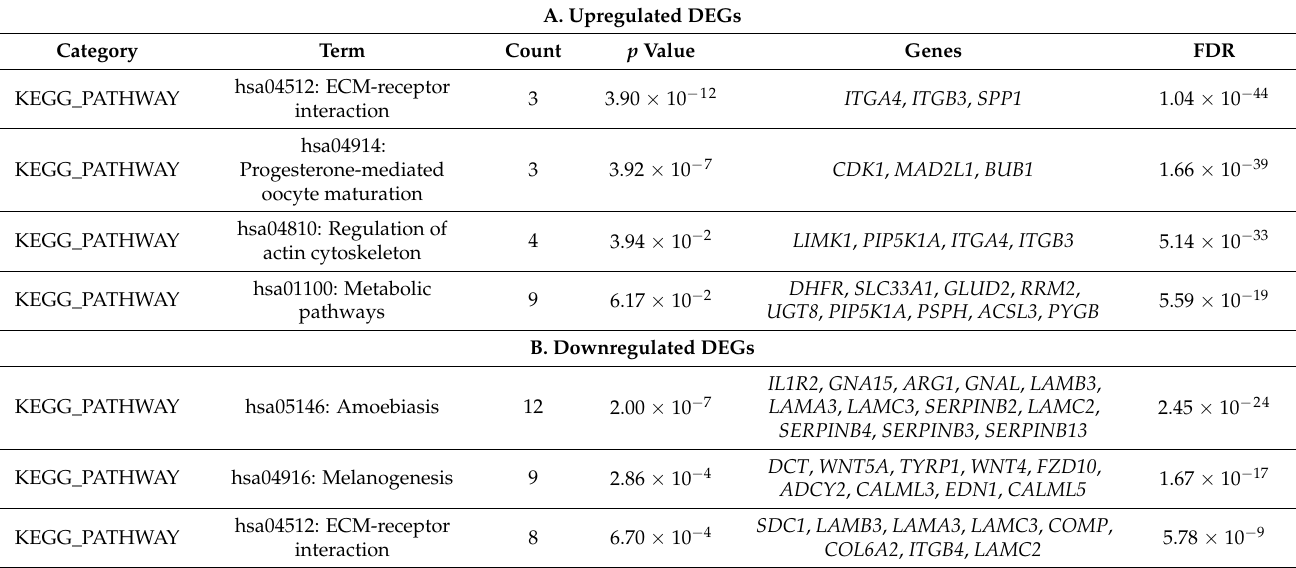
Table 2. KEGG pathway analysis of DEGs associated with melanoma metastasis.